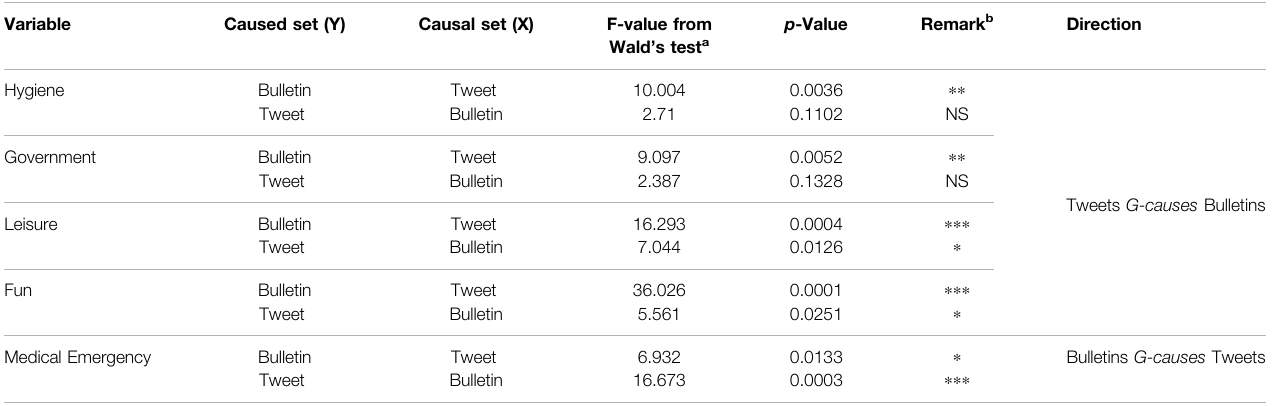
TABLE 6 | Results in respect of Granger ’ s Causality Test. Sorted by direction of the causality. Variable Caused set (Y) Causal set (X) F-value from